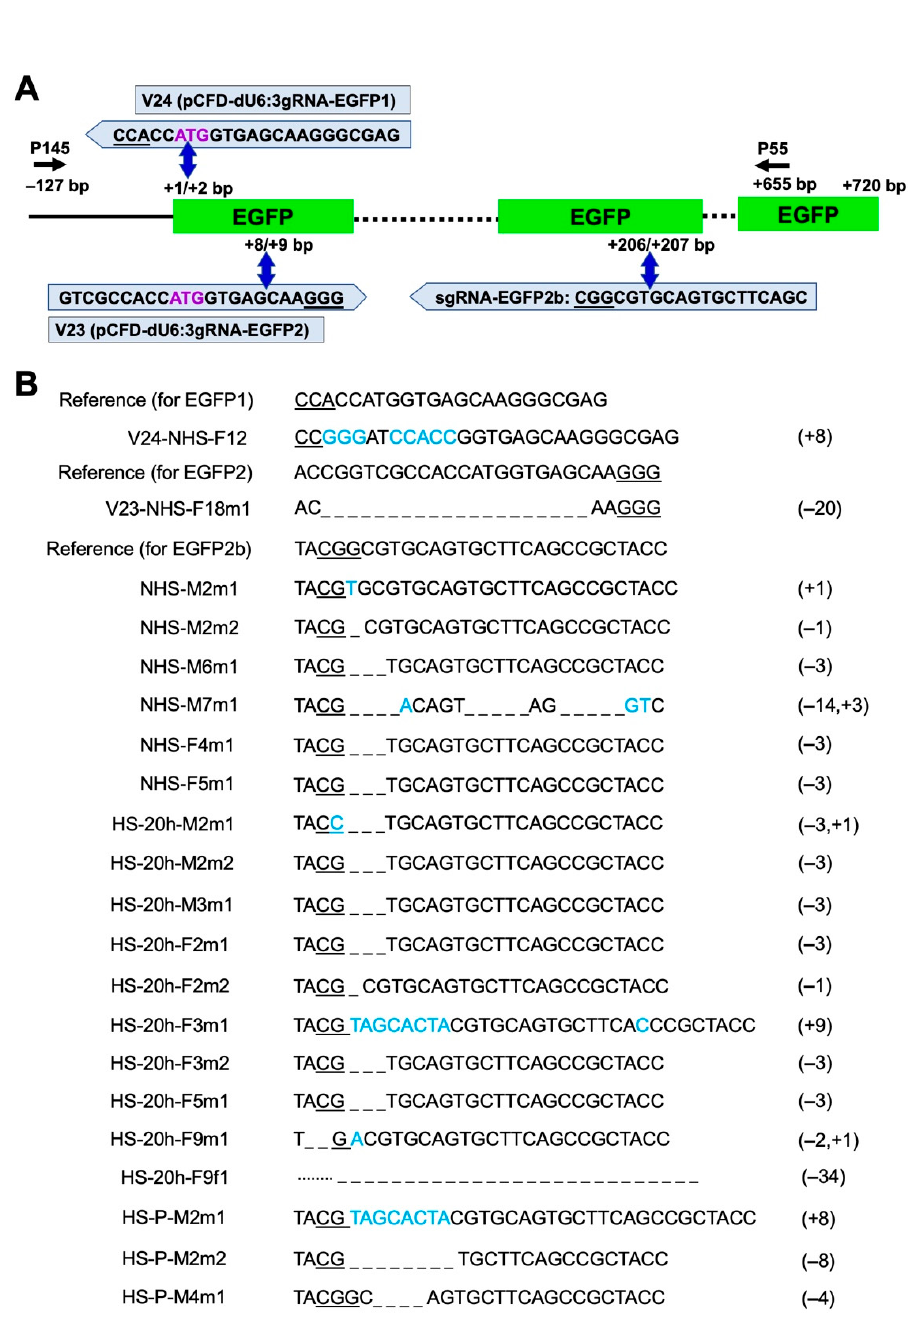
Figure 3. Targeted mutations in an exogenous EGFP gene using Cas9-expressing D. suzukii . ( A ) Position of gRNAs, protospacer adjacent motifs (PAM), double-strand breaks (DSB), and genotyping primers. The EGFP coding region in V265 construct is 720 bp (+1, +720; boxes are not to scale). PAM sequences are underlined, and predicted DSB sites are indicated by blue double-headed arrows. Plasmid V24 contains a U6:3-gRNA-EGFP1 cassette, which produces gRNA targeting the translation start codon (ATG) of EGFP (marked purple). Plasmid V23 contains a U6:3-gRNA-EGFP2 cassette, which produces gRNA targeting the 5’-proximal region of EGFP . sgRNA-EGFP2b is in vitro synthesized gRNA, and the target site is at +206/207 bp of EGFP . Relative to the EGFP sequence, gRNA-EGFP2 is sense-oriented while gRNA-EGFP1 and gRNA-EGFP2b are anti-sense-oriented. The black arrows show the PCR primers P145 (located at − 127 bp relative to EGFP ) and P55 (located at +655 bp of EGFP ), which were used to detect the mutations. ( B ) Sequences of mutant EGFP alleles identified in G1 individuals compared to the EGFP reference sequence. Mutants from certain families derived from different injections are shown on the left. V23 and V24 were injected under no heat-shock (NHS) conditions. The sgRNA-EGFP2b-injected embryos were subject to NHS or heat shock 20 h after the injection (HS-20h), or the embryos were collected from parents that subject to heat shock (HS-P). The numbers of deleted (_) or inserted (in blue) nucleotides are indicated in the brackets on the right of each